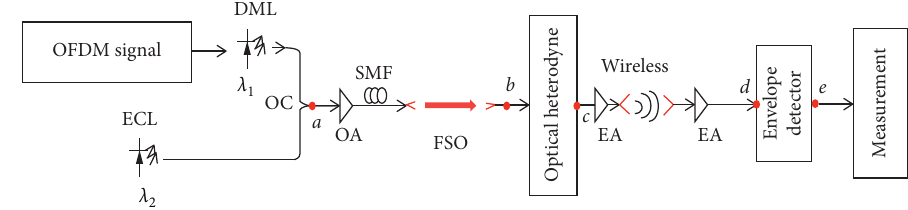
Figure 1: Structure of the integration